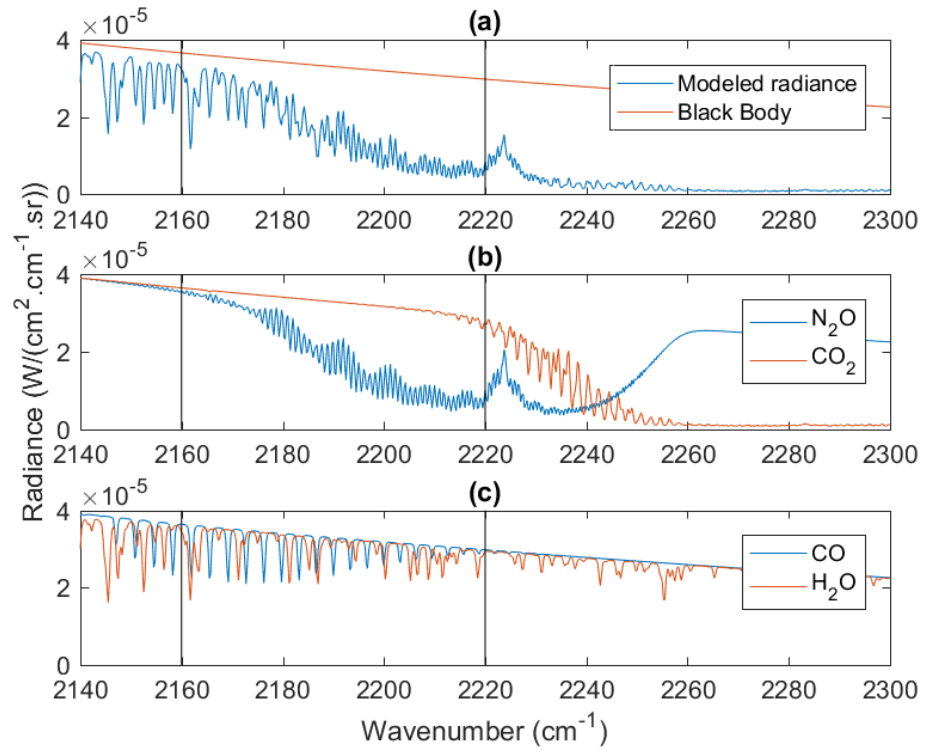
Figure 1. ( a ) simulated IASI radiance for the 2140–2300 cm − 1 spectral range, ( b ) contributions of N 2 O and CO 2 and ( c ) contributions of CO and H 2 O.The spectral window selected for the N 2 O profile retrieval (2160–2220 cm − 1 ) is indicated with the vertical